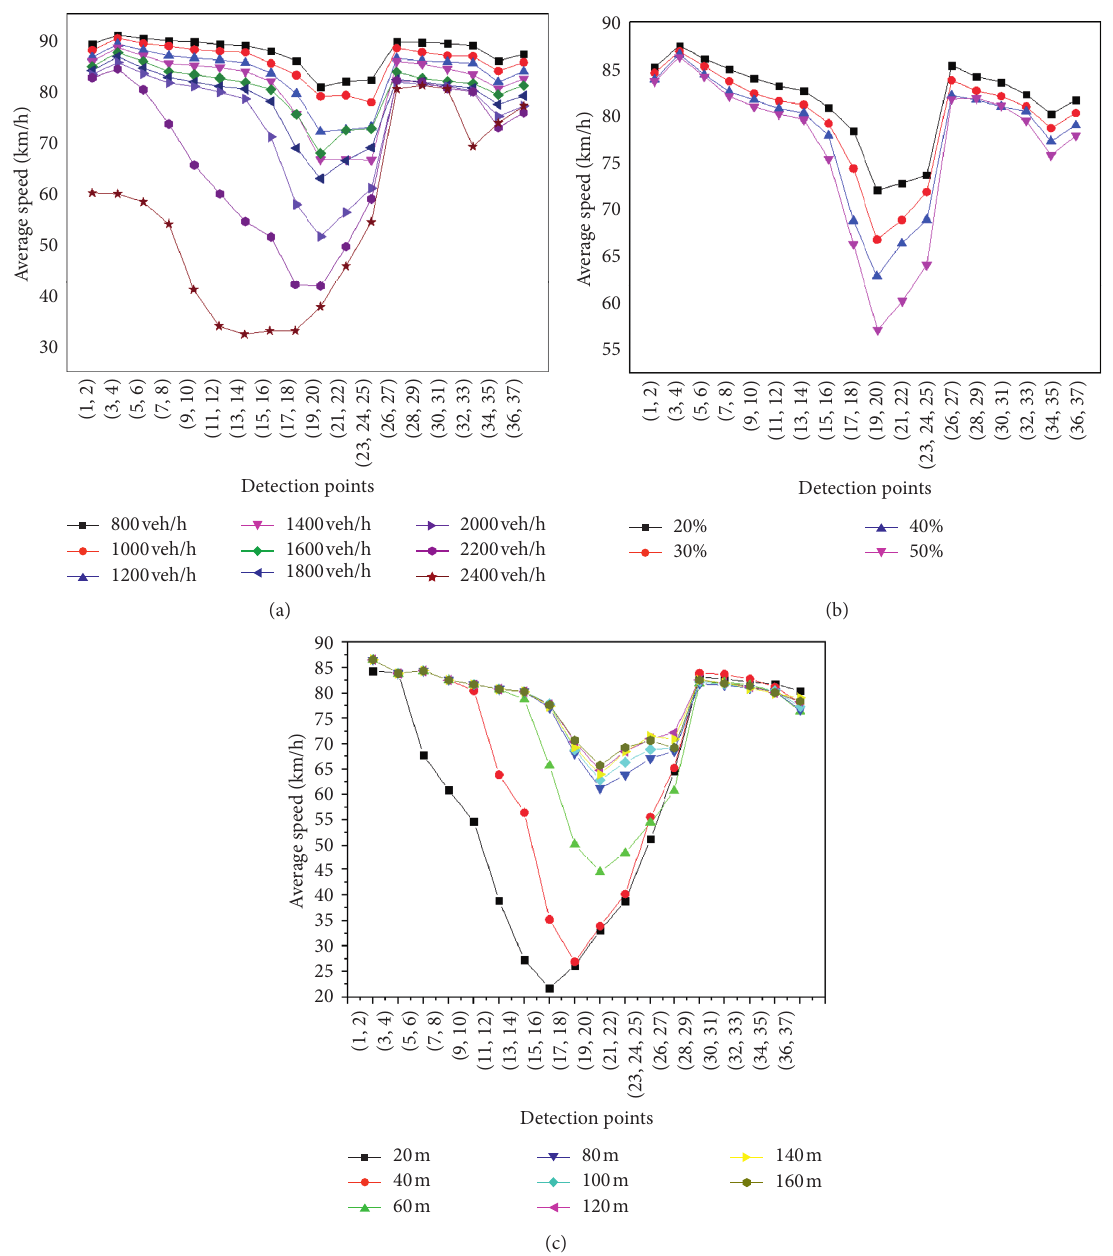
Figure 4: Average speed varies with each factor. (a) Average speed varies with traffic volume. (b) Average speed varies with the proportion of large vehicles. (c) Average speed varies with the length of the transition